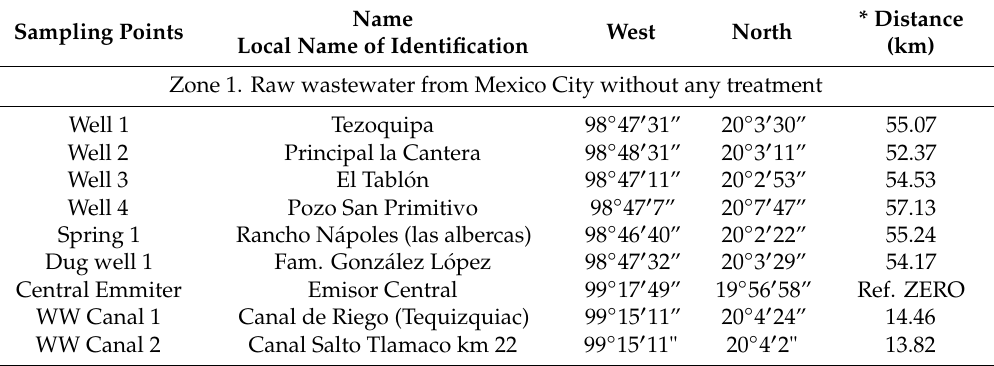
Table 1. Specific details of the sampling points for the three zones (name, location, and identification tag). Sampling